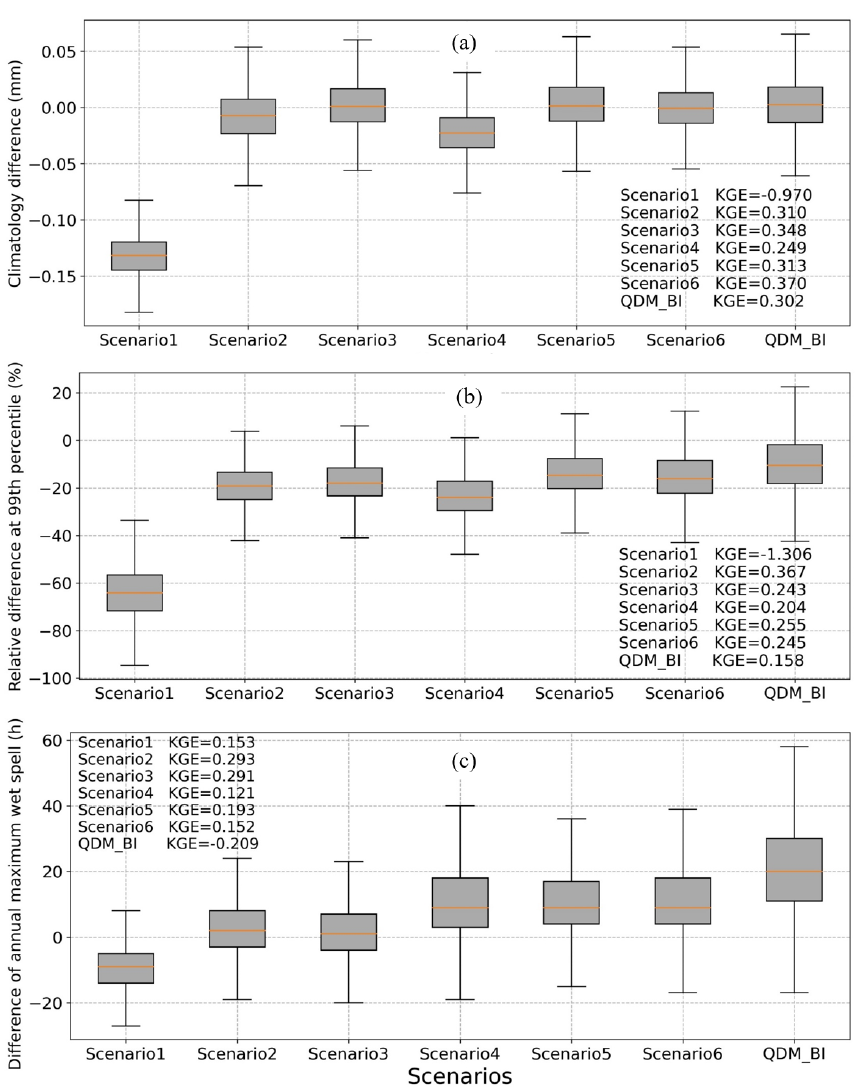
Figure 4. Boxplots showing hourly precipitation estimates minus Stage IV observations based on (a) climatology, (b) extreme at 99% percentile, and (c) annual maximum wet spell in hours during the testing period (2019–2021). Precipitation estimates are produced from the QDM_BI approach and 6 DL experimental runs